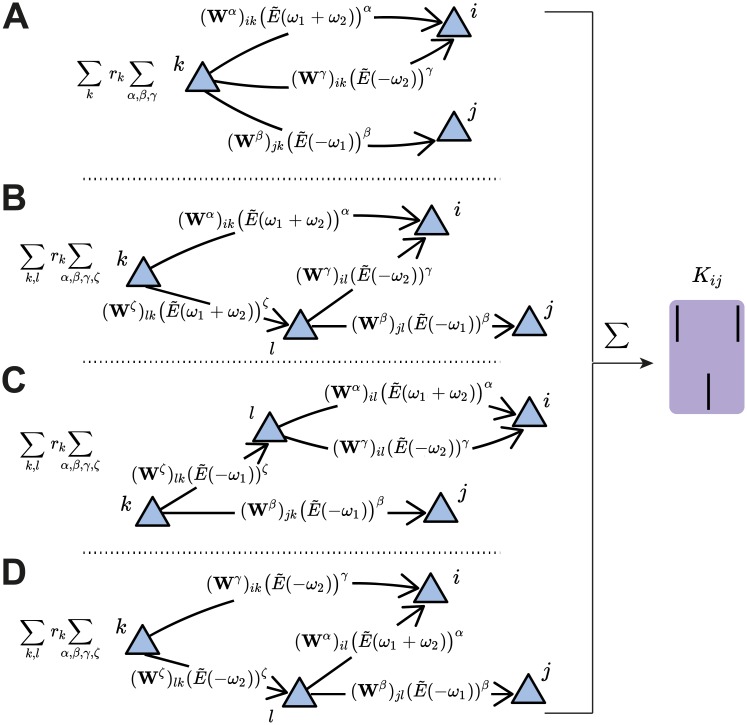
Third-order cumulant contributions to plasticity can be broken down into four terms.A. The first term contains all the α-, β- and γ-paths originating from the source neuron k to the spiking neurons i and j. B-D. The other terms take into account the possibility of an intermediate neuron l that acts as a new source neuron for two of the paths. These are referred to as ‘branched paths’, and the path length from the source neuron k to the intermediate neuron l is denoted with ζ. The branching describes the individual terms in Eq 5.